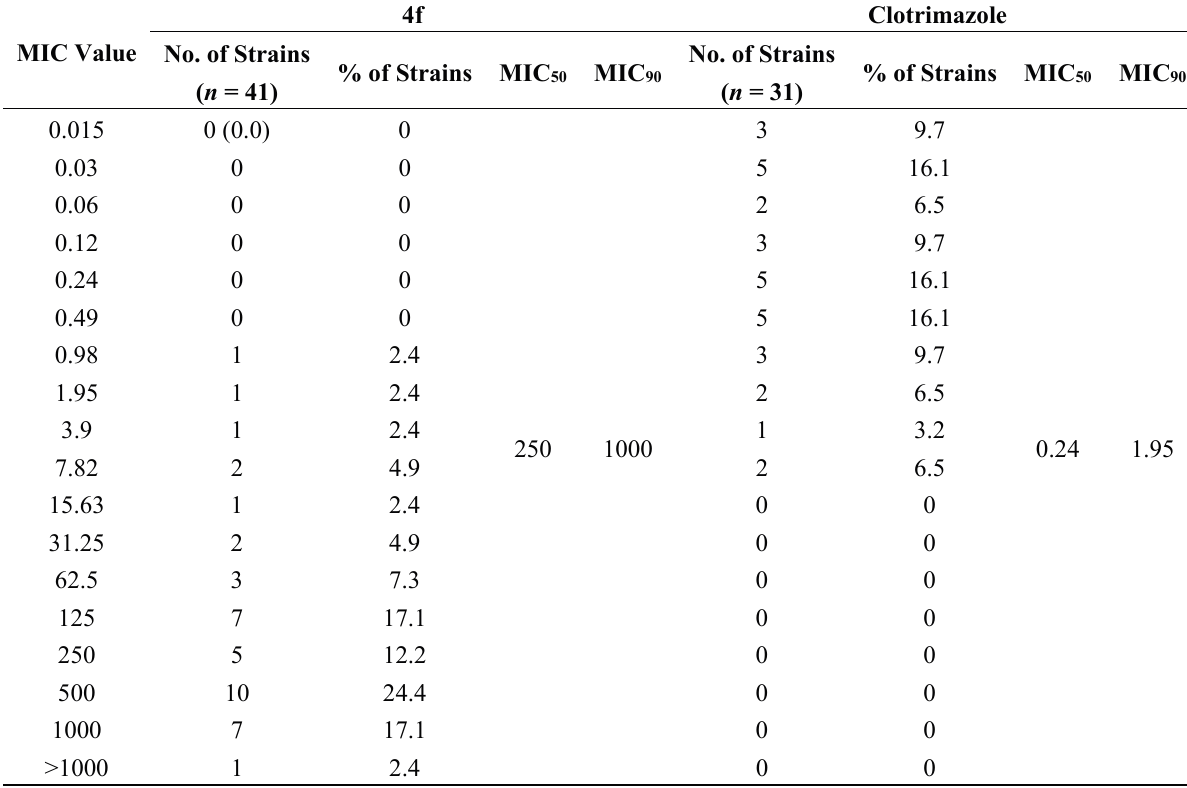
Table 2. Activity of 4f and clotrimazole against clinical strains of Candida albicans detected on the basis of minimal inhibitory concentration (MIC, mg/L)